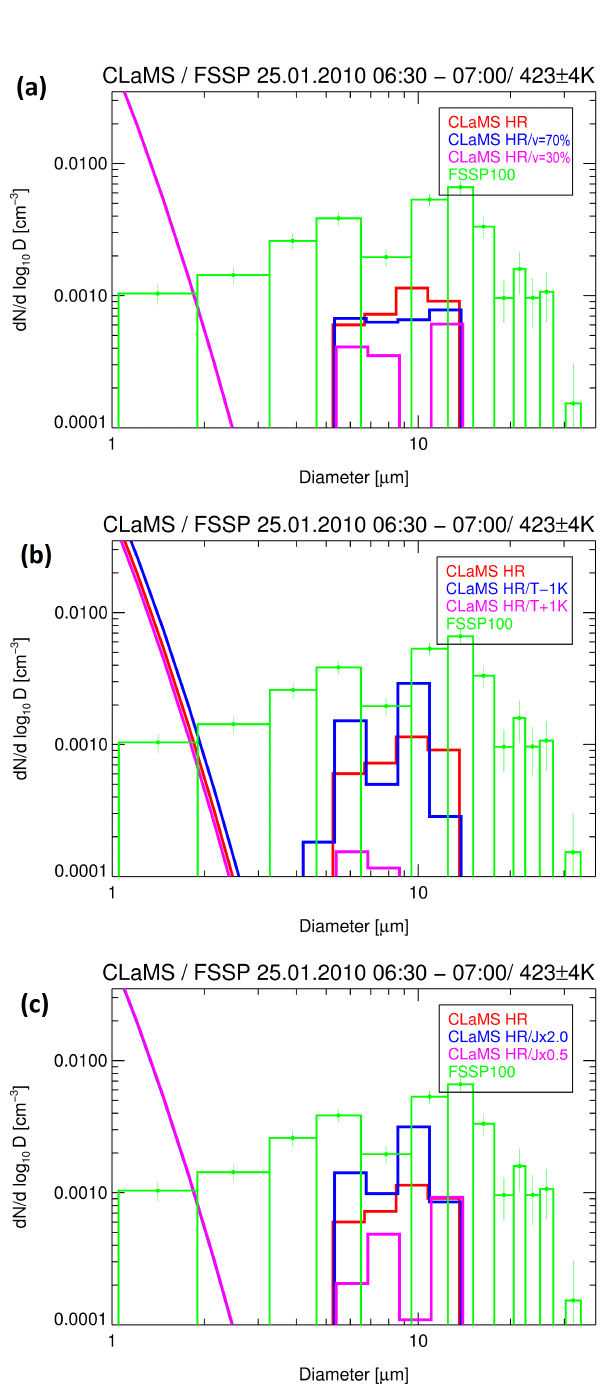
Figure 1. FSSP-100 size distribution derived for the time interval 06:30 to 07:00UTC of the flight through a PSC on 25 January 2010 (flight altitude 18km) assuming spherical particles. Additionally, the associated size distributions corresponding to the CLaMS ref- erence simulation (CLaMS HR) and alternative scenarios consid- ering reduced settling velocities of NAT particles ( v = 70% and v = 30%, top panel), temperature biases of ± 1K ( T − 1K and T + 1K, middle panel) and modified nucleation rates (J × 0.5 and J × 2.0, bottom panel) (compare Sect. 5) are